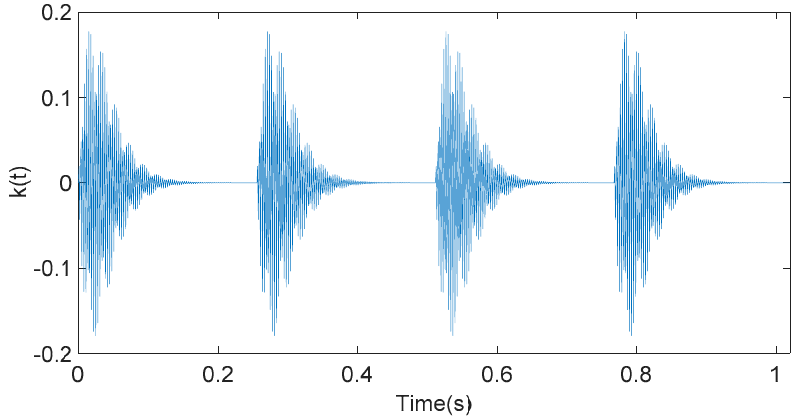
Figure 1. Time-domain waveform of the simulation component signal k ( t )